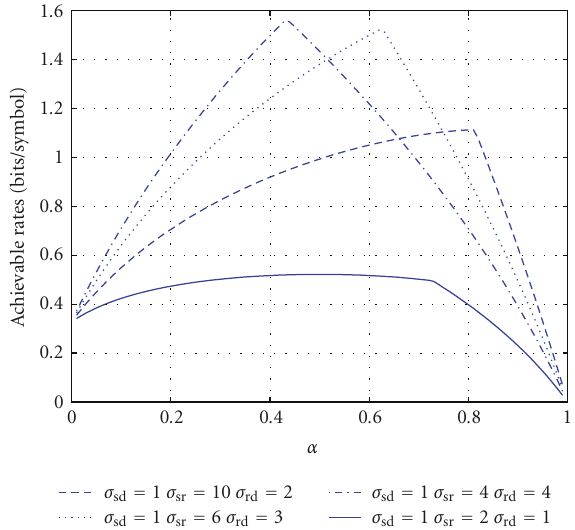
Figure 9: Nonoverlapped DF parallel coding achievable rate versus α when P s = P r = 0 . 5, δ s = δ r = 0 . 1, and m = 50.